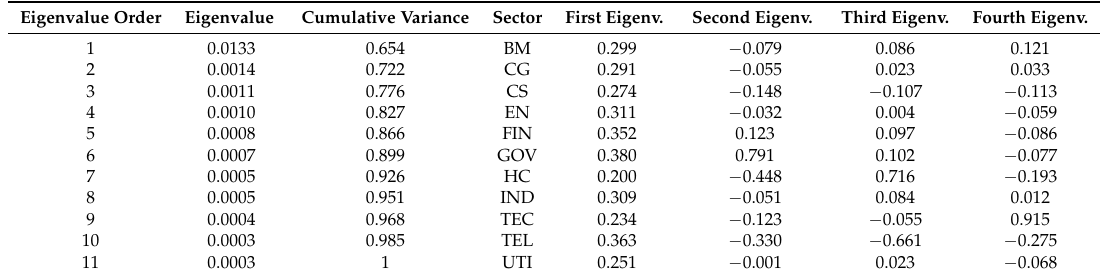
Note: The table shows the eigenvalues of the matrix of standardized weekly changes in the sectorial credit indices, the cumulative variance explained by the eigenvectors, and the coefficients of each of the first four eigenvectors on the 11 sectorial indices. The order of the sectors is shown in column